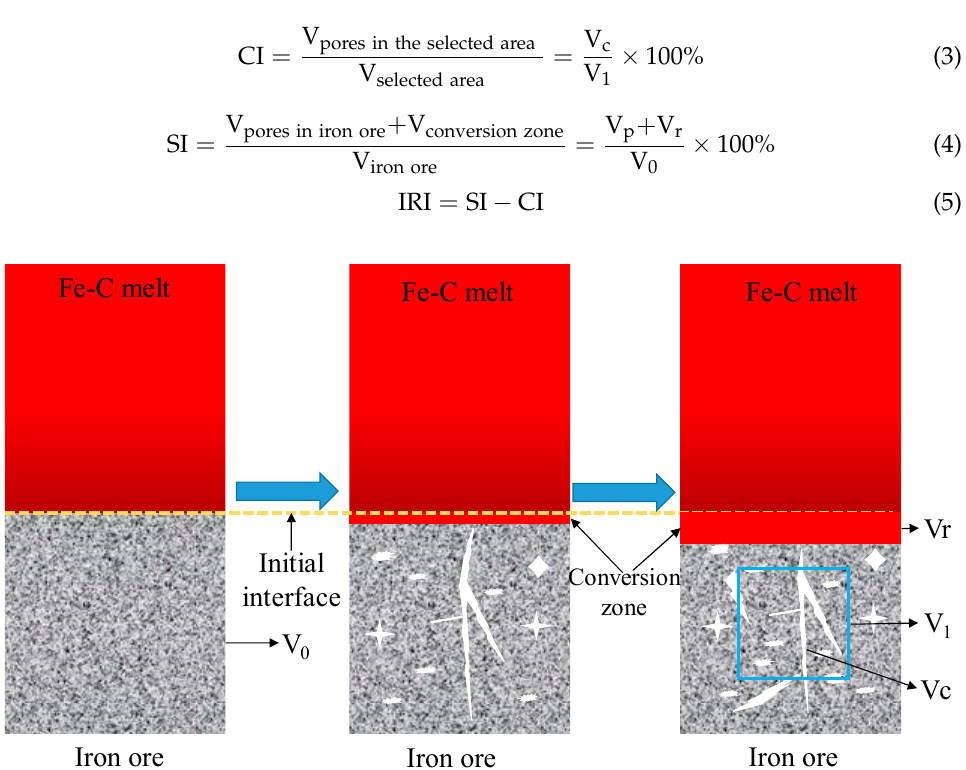
Figure 11. Schematic diagram of interfacial reaction and internal crack development in two-dimensional state.